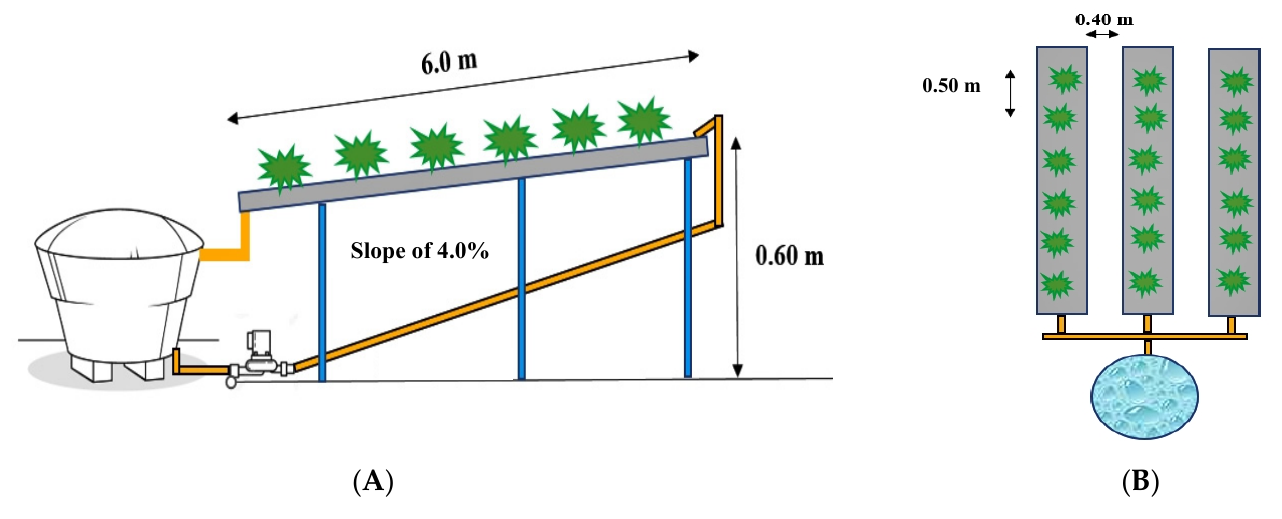
Figure 2. Side view ( A ) and top view ( B ) of the hydroponic system used in the study. The sowing was conducted in polyethylene cups of 50 mL capacity containing veg- etable sponges of the genus Luffa ( Luffa aegytiaca ) arranged in trays. The sponges were sanitized using sodium hypochlorite (2.5%) before sowing. From germination to the emer- gence of the first true leaf (on average ten days after sowing), a half-strength (50%) nutrient solution was used. The vegetable sponge was removed after the emergence of the first true leaf, the seedlings were inserted directly into the hydroponic channels, and a full-strength nutrient solution was employed.